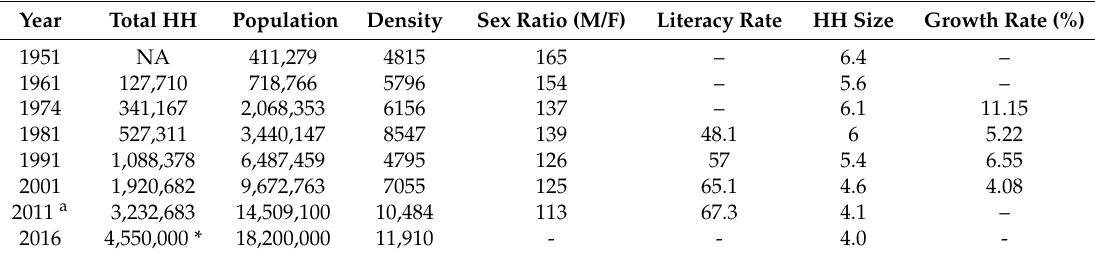
Table 1. Demographic characteristics of Dhaka megacity.